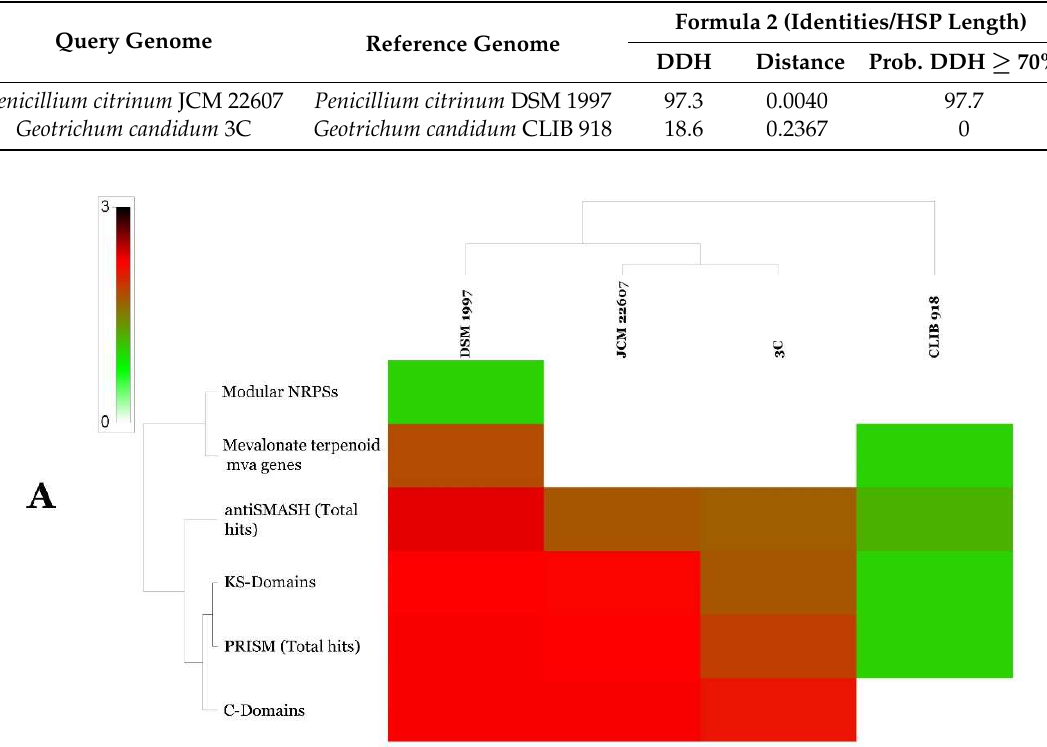
Table 3. GGDC values for Penicillium citrinum and Geotrichum candidum isolates.